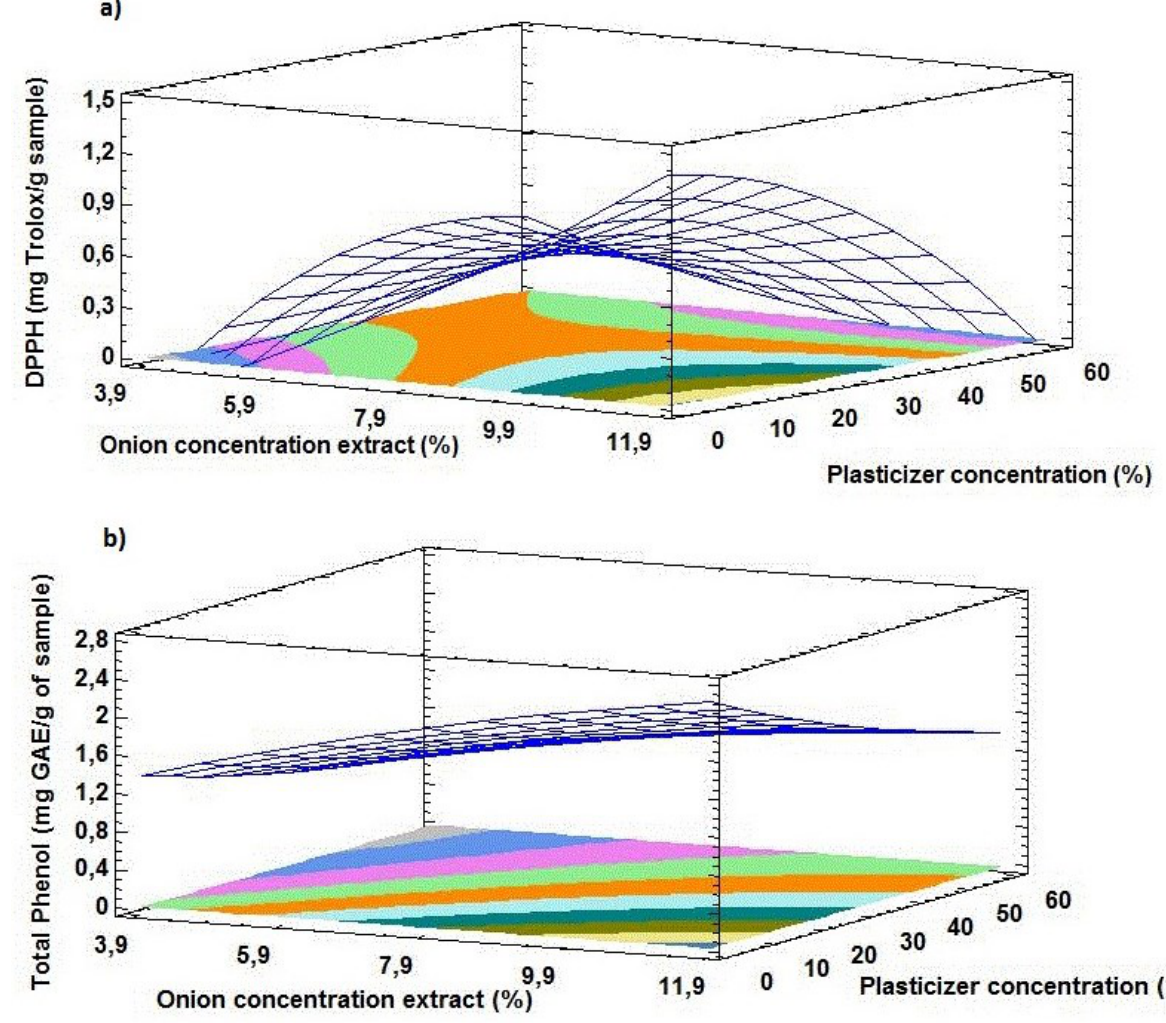
Figure 1. The surface plots of ( a ) total phenol and ( b ) DPPH radical-scavenging activity of forming film process by the plasticizer and onion